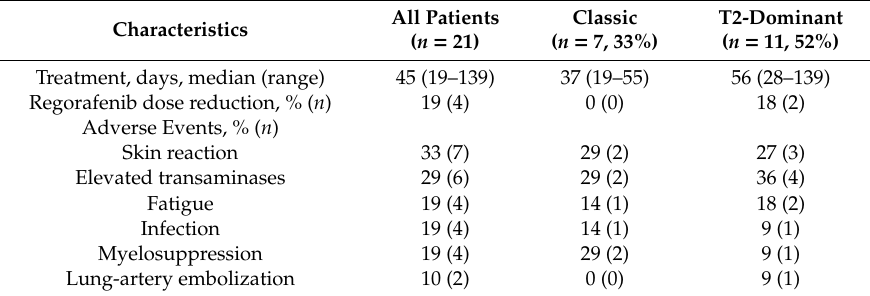
Table 2. Safety profile.